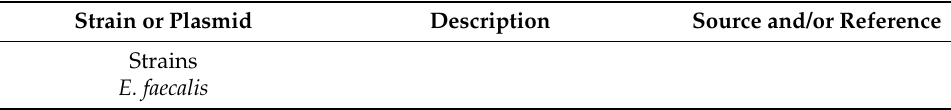
Table 1. Bacterial strains and plasmids used in this